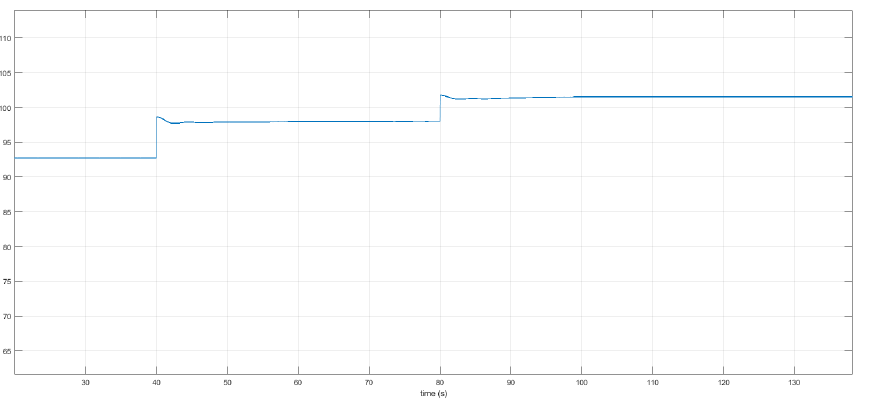
Figure 11. The active power generated by conventional synchronous generators units in the area